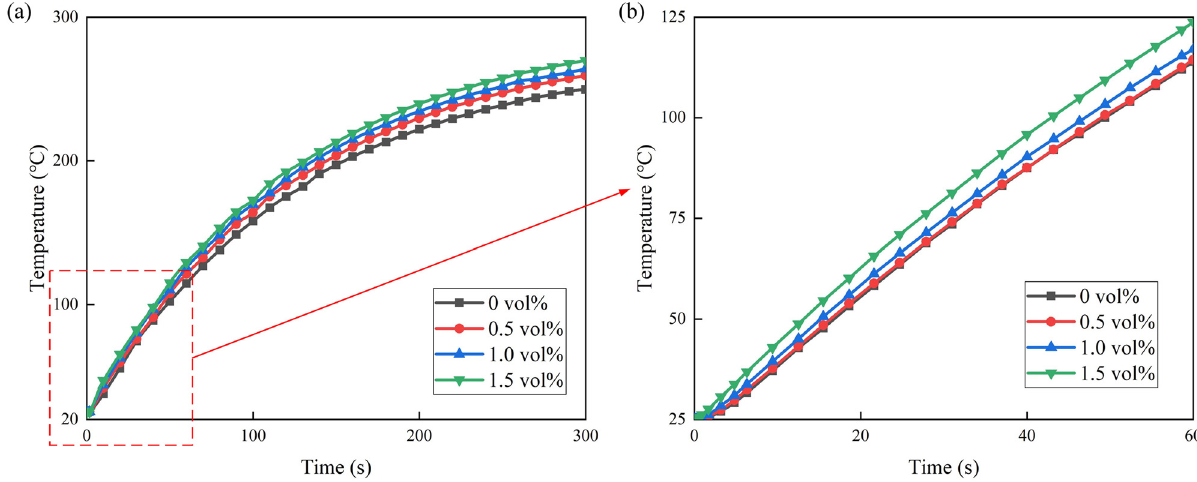
Figure 14: Temperature - rising curves with di ff erent GO contents: ( a ) 0 – 300 s, and ( b ) 0 – 60